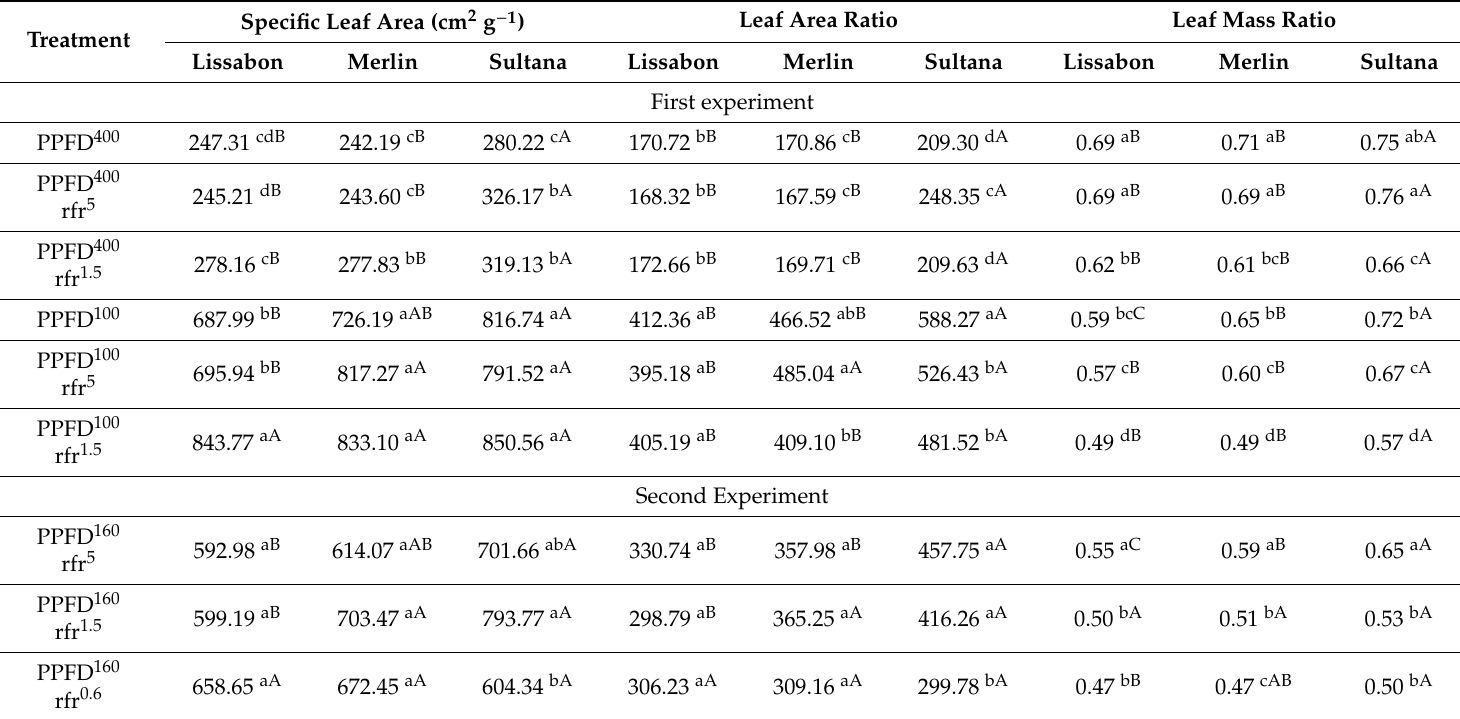
Table 6. The least square means of specific leaf area, the leaf area ratio, and the leaf mass ratio for the three cultivars in the first (top) and second (bottom) experiment. For each experiment, lower case letters indicate significant di ff erences between treatments for each cultivar, and upper case letters indicate significant di ff erences between cultivars for each treatment ( p <